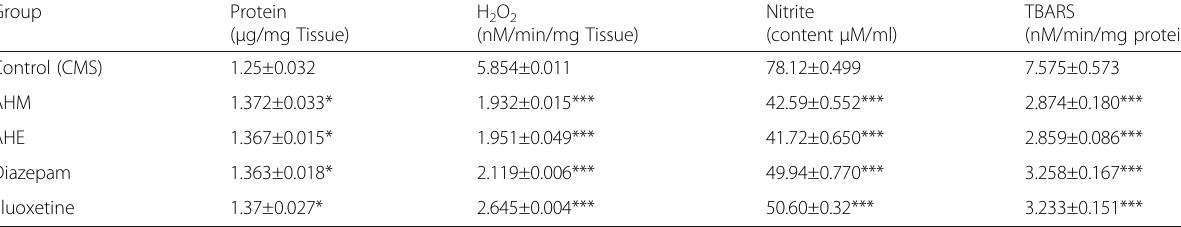
Table 5 Effect of oral dose of AHM and AHE for 7 days on brain tissue protein and oxidative stress markers Group Protein ( μ g/mg